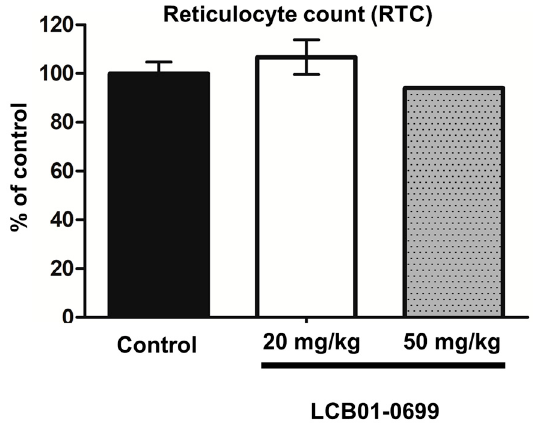
Figure 4. Myelosuppression toxicity of LCB01-0699 . Each bar represents mean ± SD.